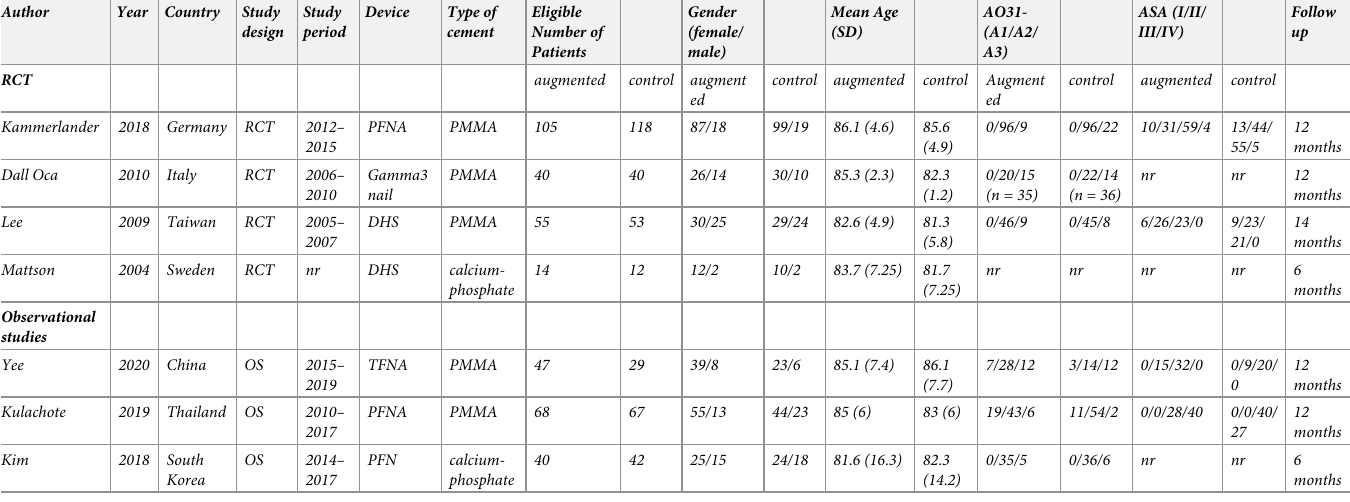
Table 1. Baseline